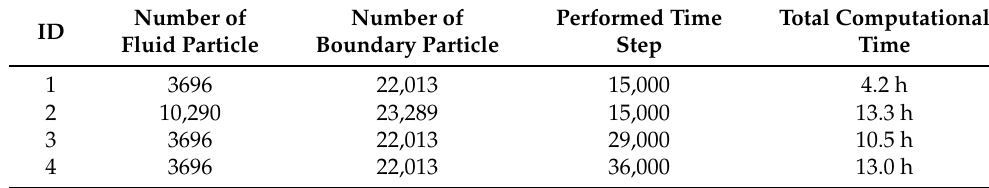
Table 7. The relationship among the number of particles, computation time, and step size in all